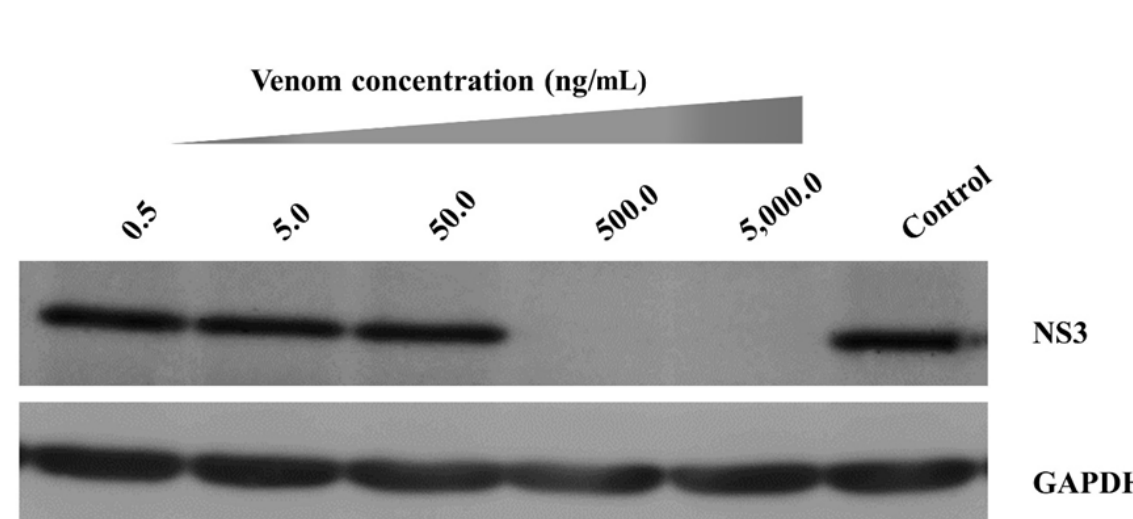
and CC of wasp venom against hepatitis C 50 50